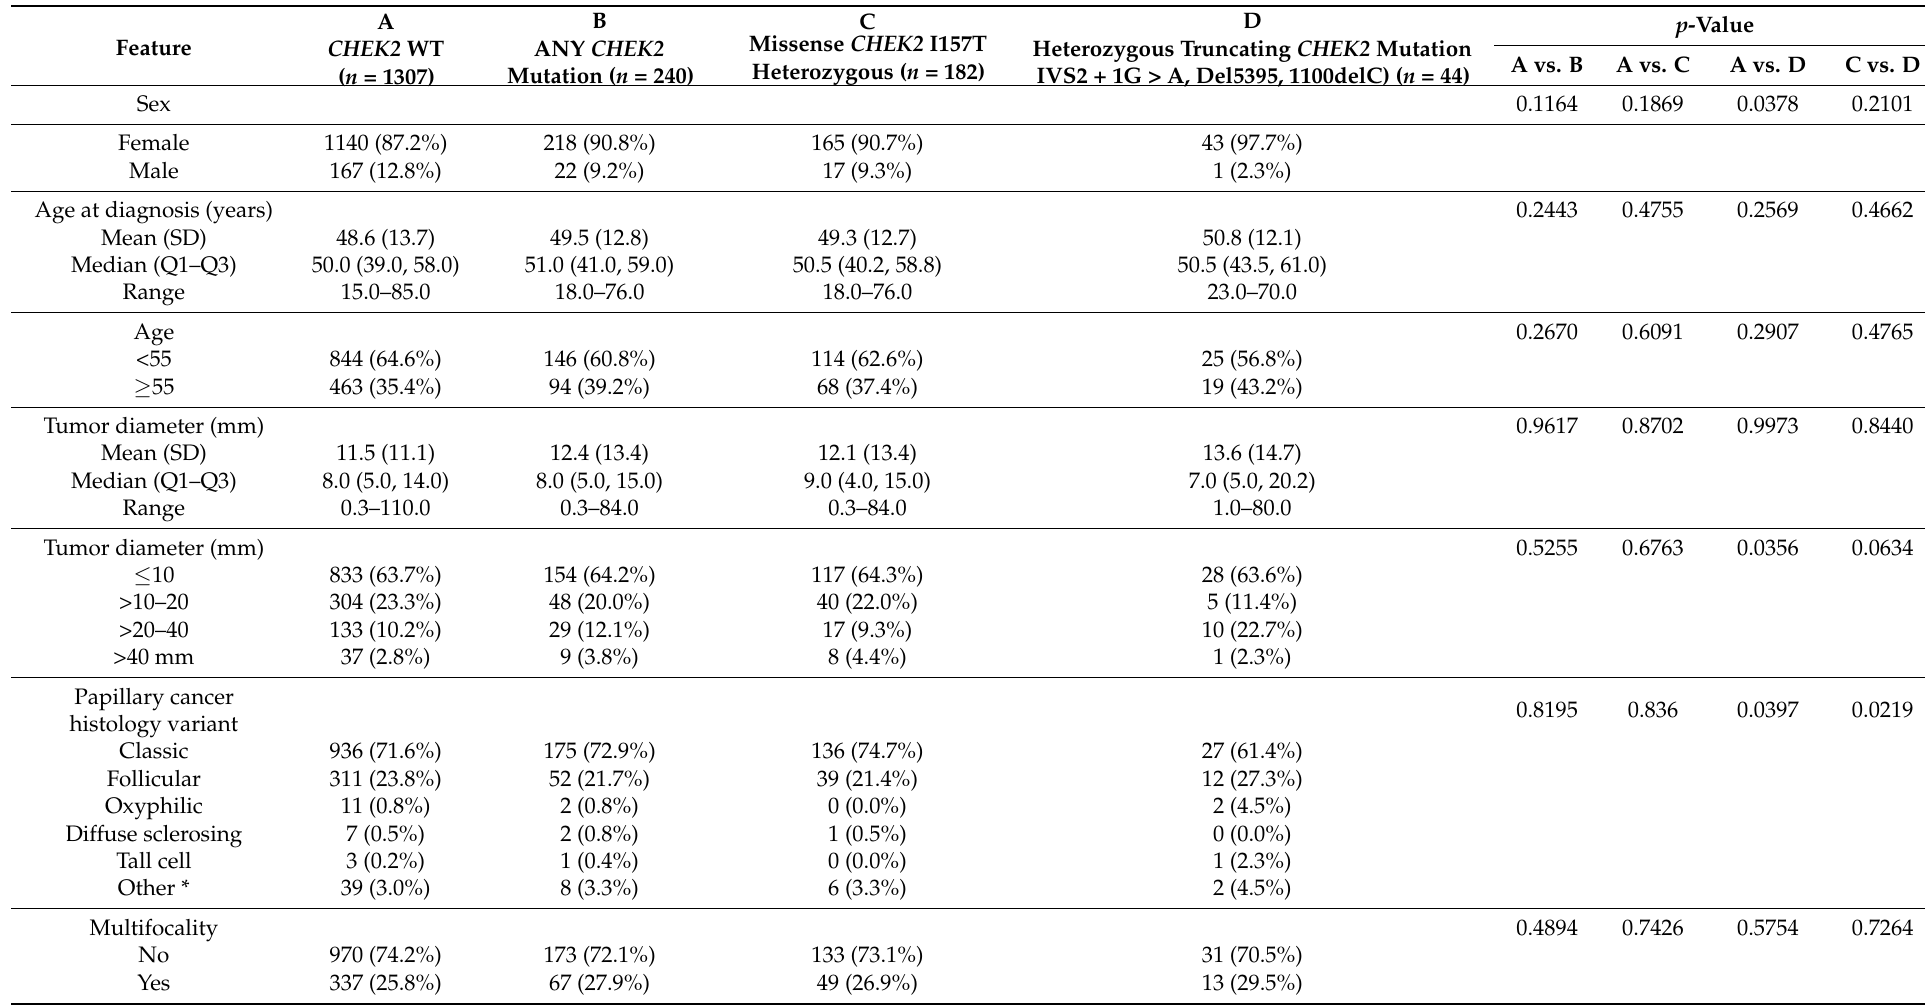
Table 3. Impact of different CHEK2 variants on clinicopathological features, response to therapy, and disease